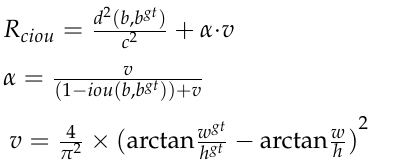
S × S denotes the grid of the detection layer, and B denotes the number of bounding boxes in each grid. The boxes containing the ground truth center of the object are counted before training, and classification and confidence loss are calculated for these boxes. The rest of the boxes that do not contain objects only calculate the confidence loss. Both classi- fication loss and confidence loss are calculated using binary cross-entropy, which is cal- culated in Formula (8). =